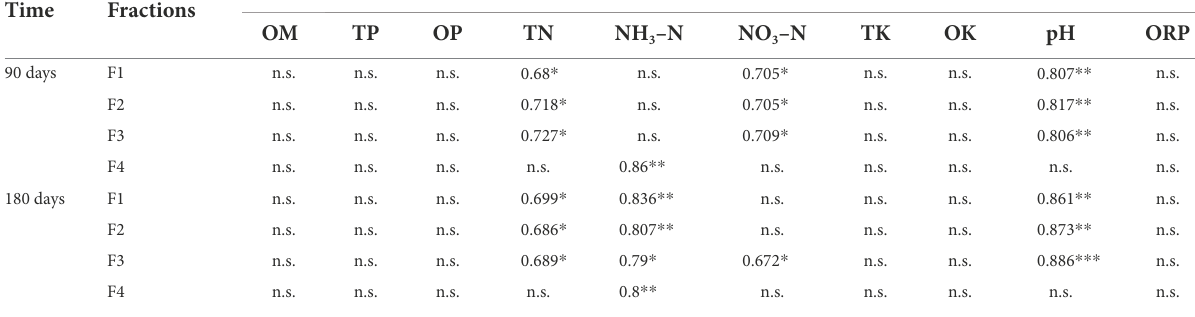
TABLE 1 Relationships between four fractions of Cr and soil properties were also shown by Pearson’s correlation analysis.